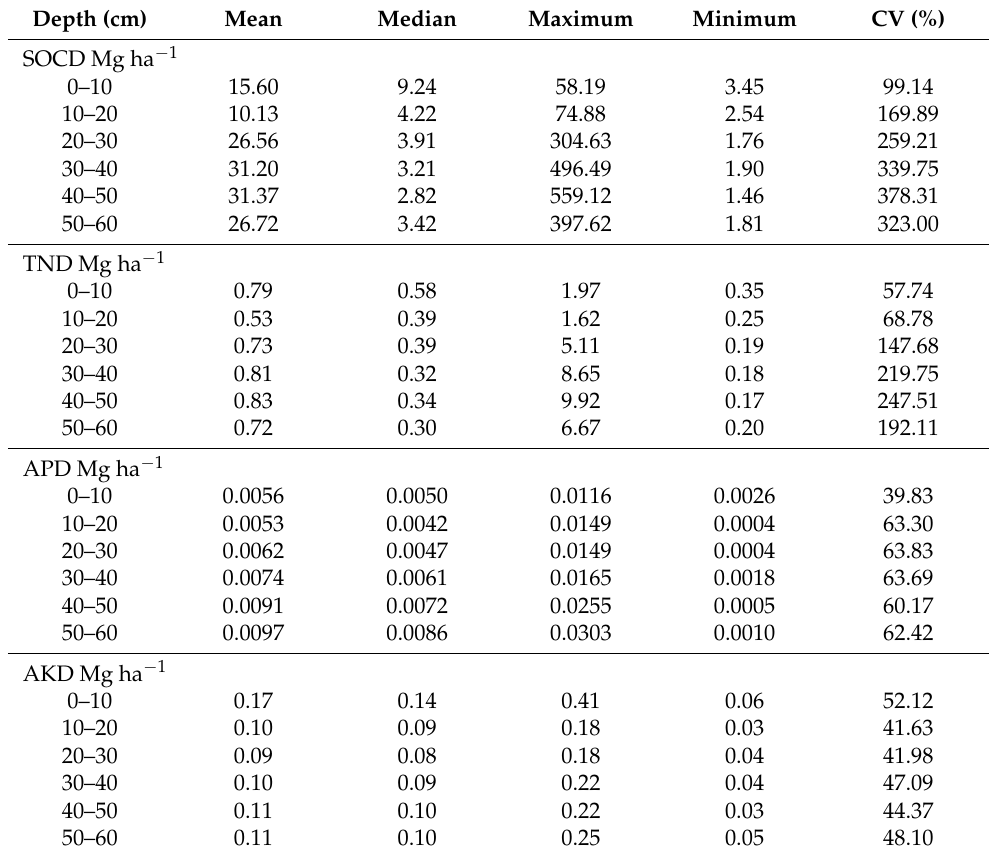
Table 1. The calculated SOCD, TND, APD, and AKD in different soil horizons.